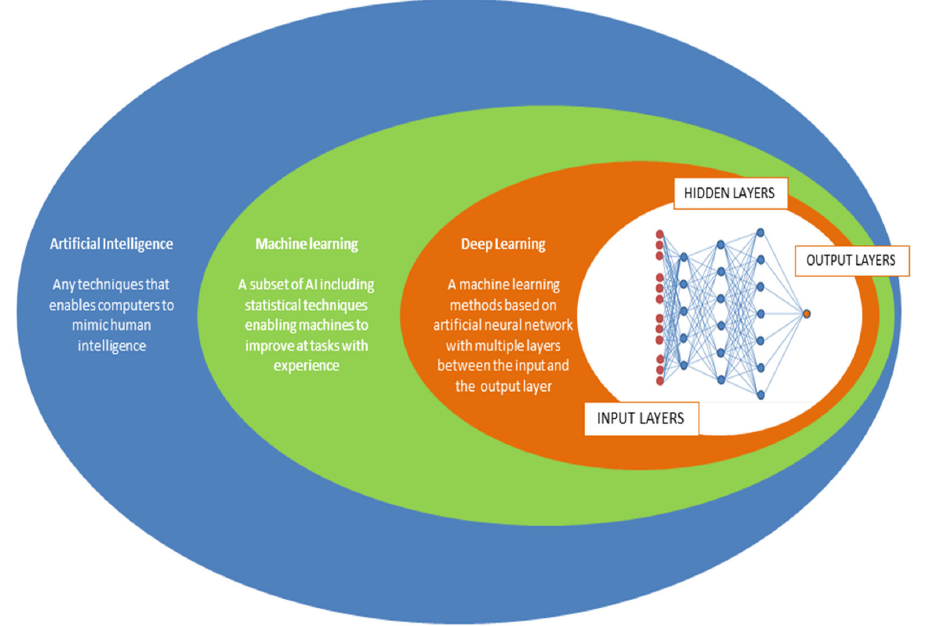
Figure 1. Neural networks and subsets of arti fi cial intelligence.